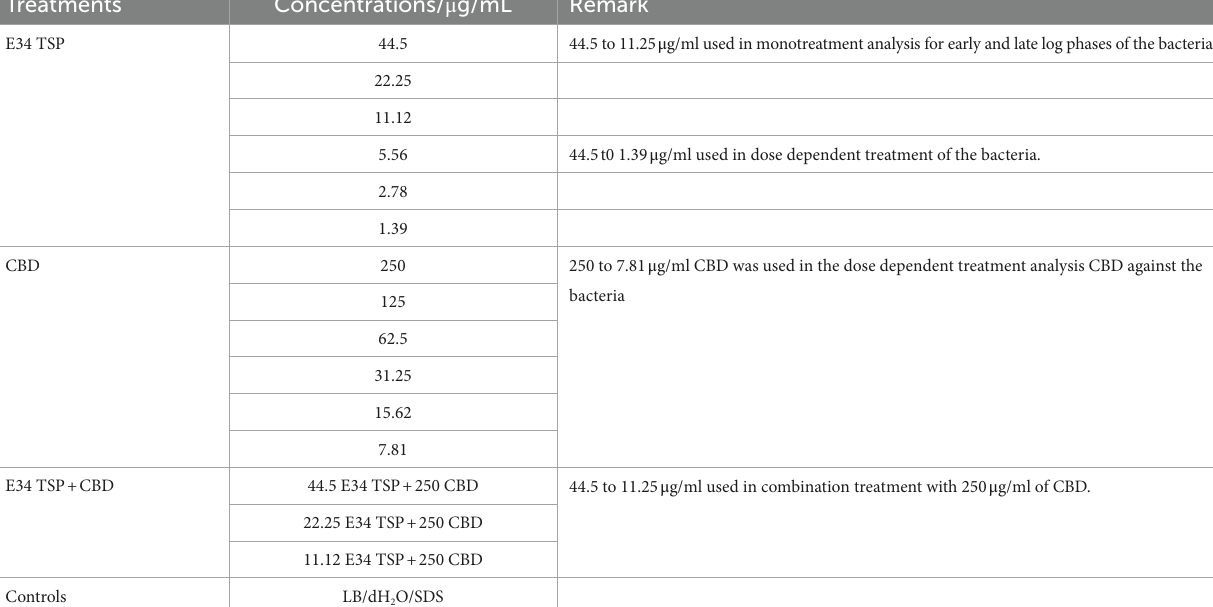
TABLE 1 Treatments. Treatments Concentrations/ μ